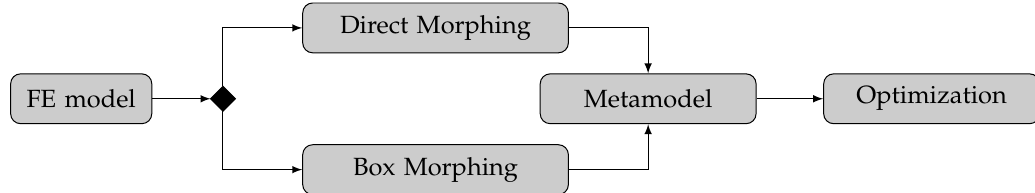
Figure 2. Workflow from initial finite element (FE) model to